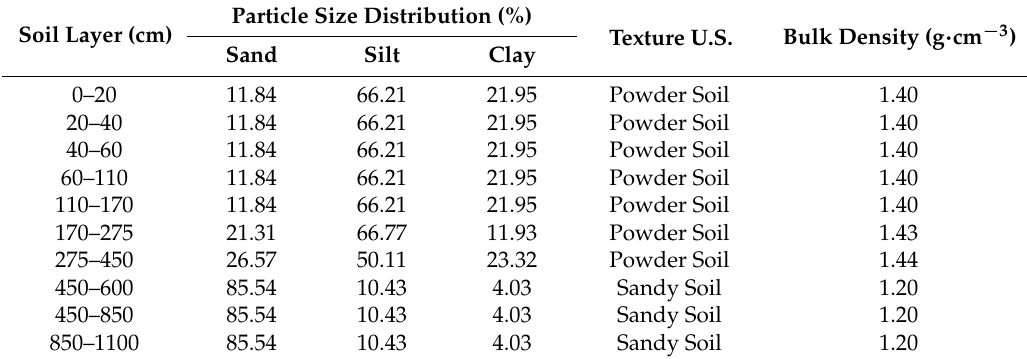
Table 1. Physical soil properties at the experimental site.